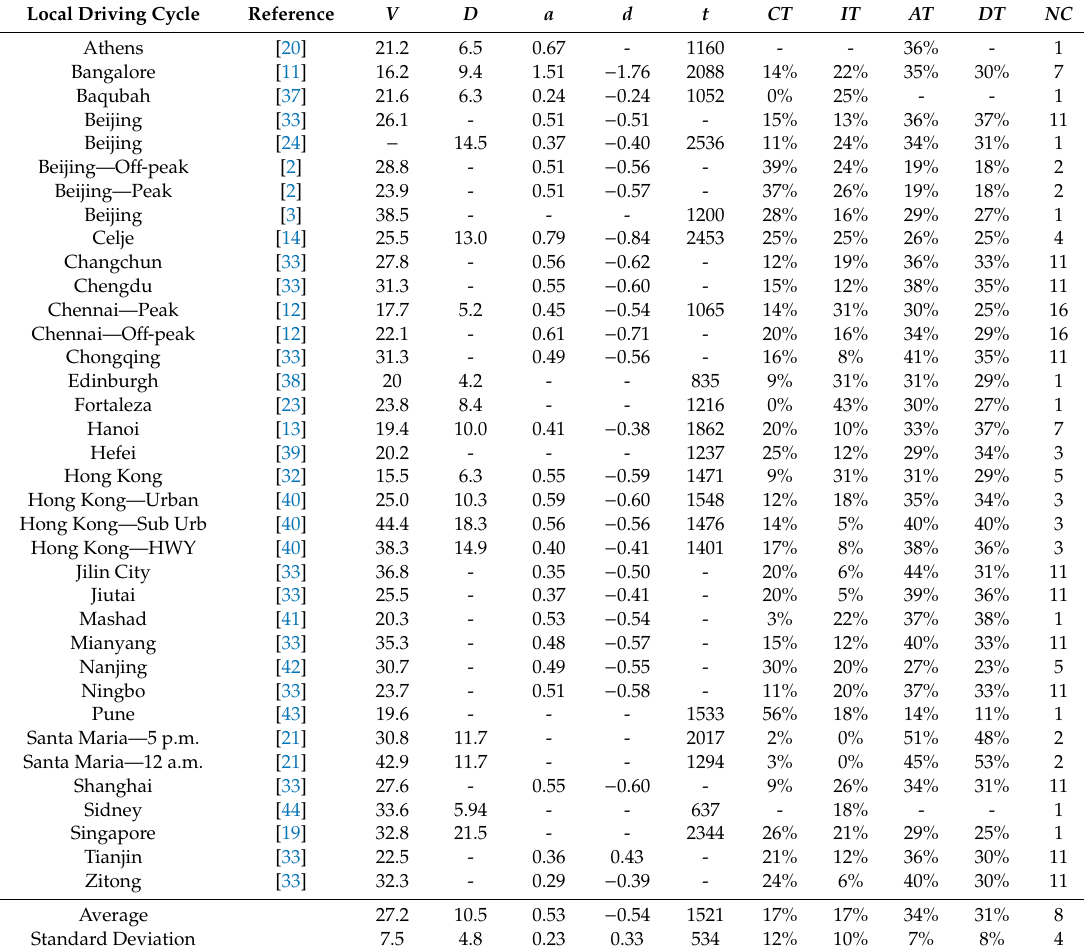
Table 4. Original characteristic kinematic parameter (CP ORIG ) for the LDCs for passenger cars (PCs). Local Driving